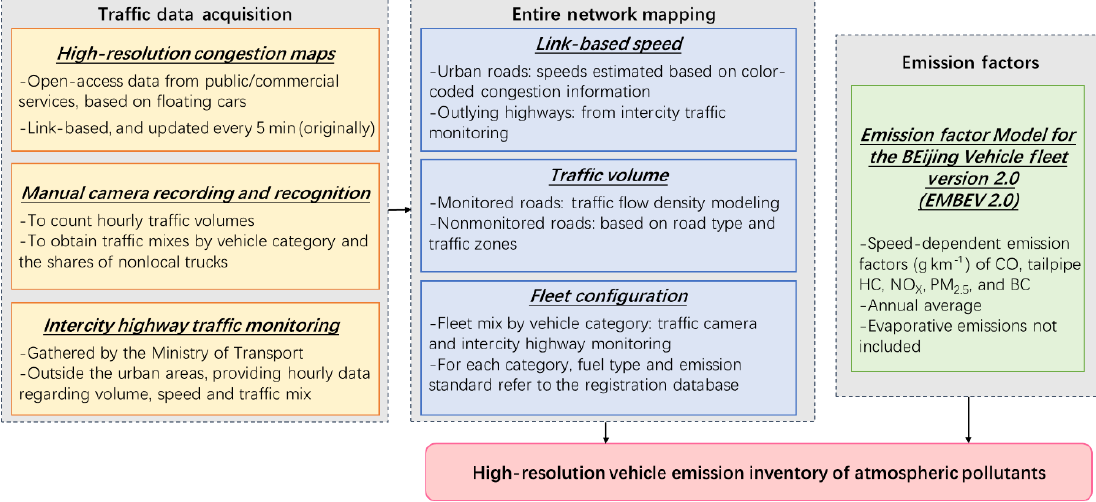
number of nonlocal HDTs at the representative road sites and distinguished volume allocation for local and nonlocal traffic during different hours during the night (Zhang et al.,